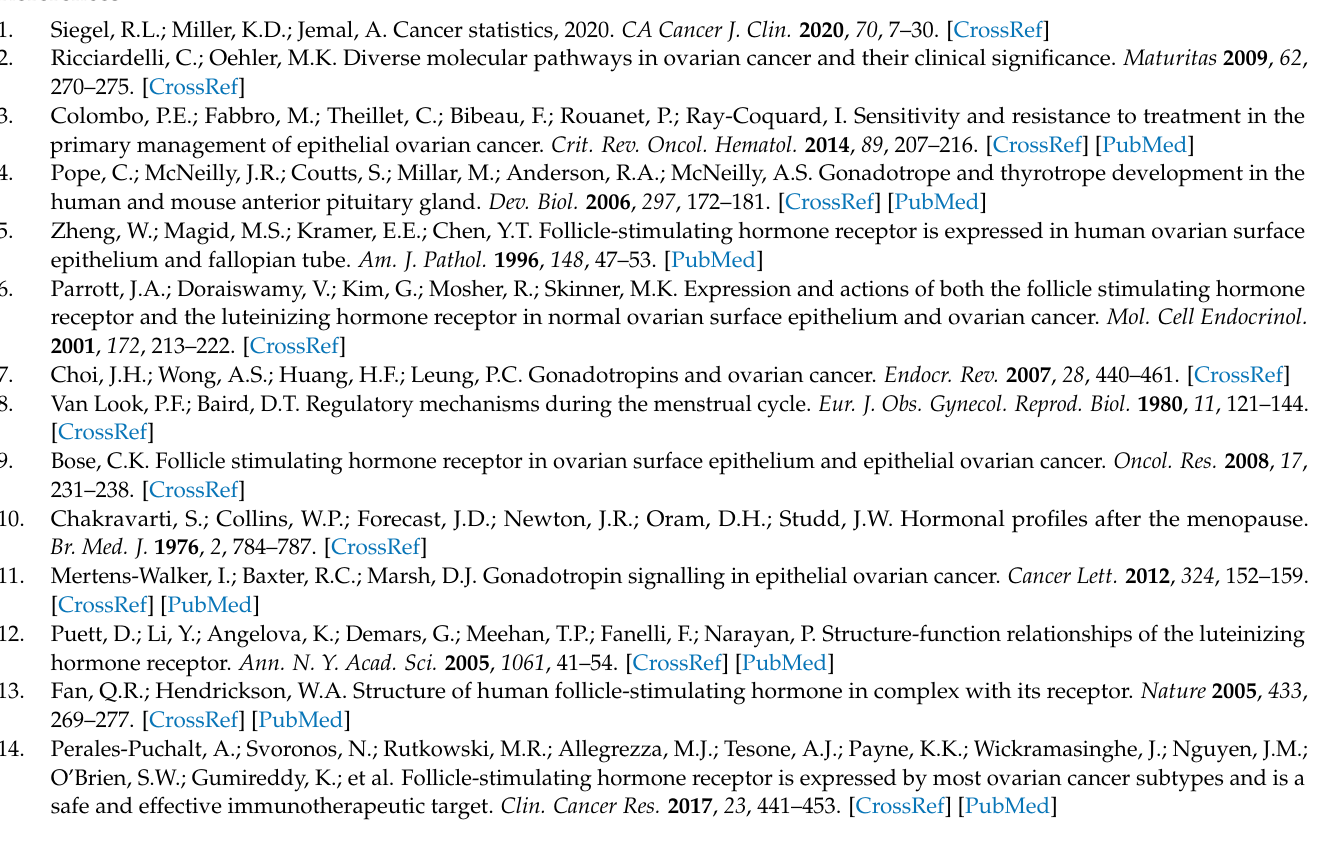
parameters. Figure S1. Human FSHR and LHCGR splice variants. Figure S2. Follicle-stimulating hormone receptor (FSHR) and luteinising hormone receptor (LHCGR) expression in human ovary. Figure S3. Western blot using FSHR323 antibody. Figure S4. Effect of follicle-stimulating hormone receptor ( FSHR ) siRNA treatment on FSHR protein expression in OVCAR3 and COV362 cells. Figure S5. Effect of luteinising hormone receptor ( LHCGR ) siRNA treatment on LHCGR mRNA and protein expression in OVCAR3 and COV362